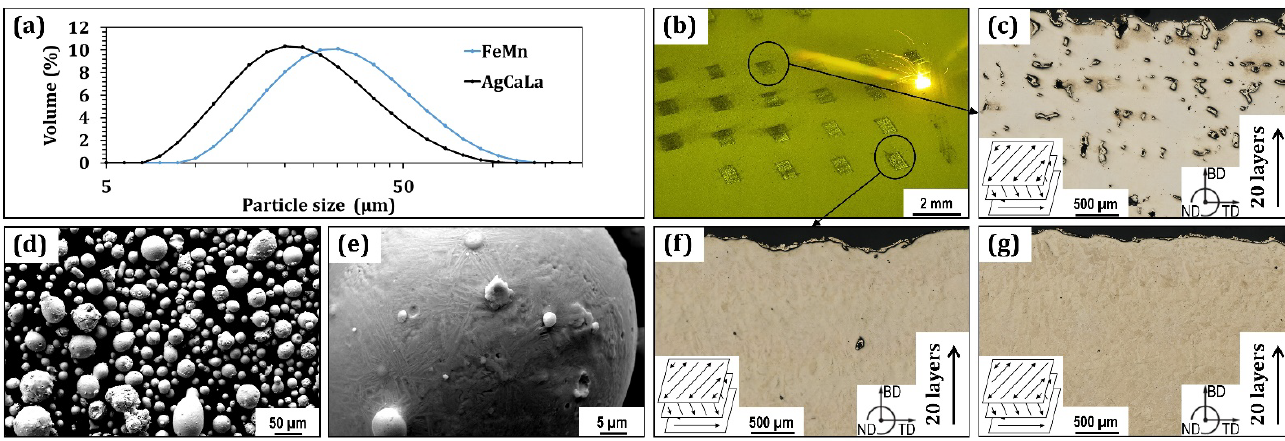
Figure 1. ( a ) PSD of powder feedstock; ( d , e ) SEM-SE: gas-atomized AgCaLa particles; ( b ) processing via LBM with different parameter settings; ( c , f , g ) LM: cross-section of samples with varying AgCaLa content in the bulk material process strategies: ( c ) LD-2, ( f ) LSC-2, ( g ) LSC.